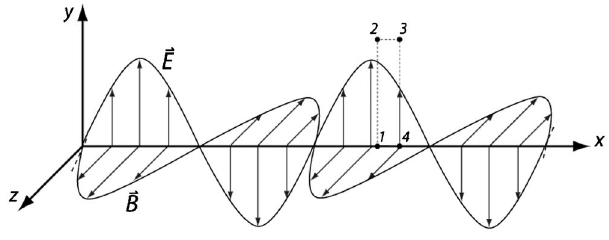
FIG. 2. EM wave picture from part 2 of the tutorial. This picture was used in both the initial and follow-up studies.